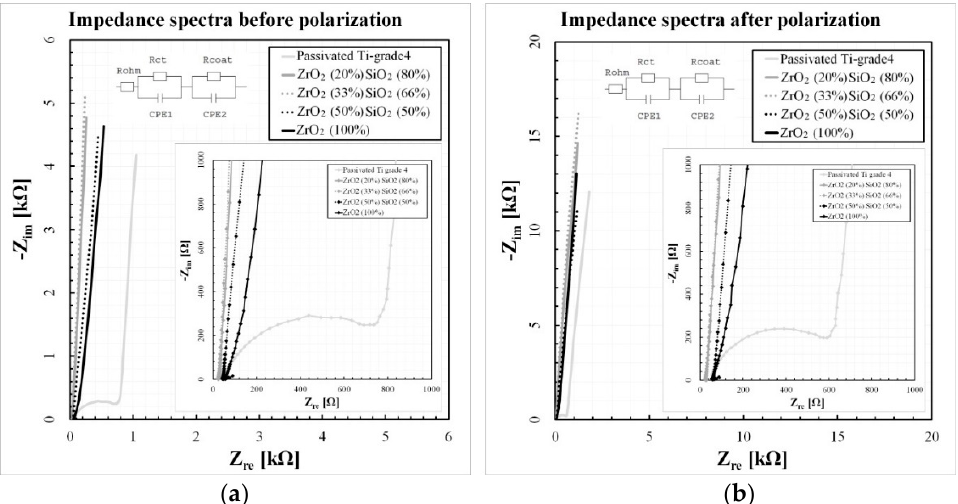
Table 3 . Corrosion currents (I cor ) and corrosion potentials (E cor ), calculated via Tafel analysis on the potentiodynamic plots of the different samples and their corresponding protection efficiency (%P.E.).